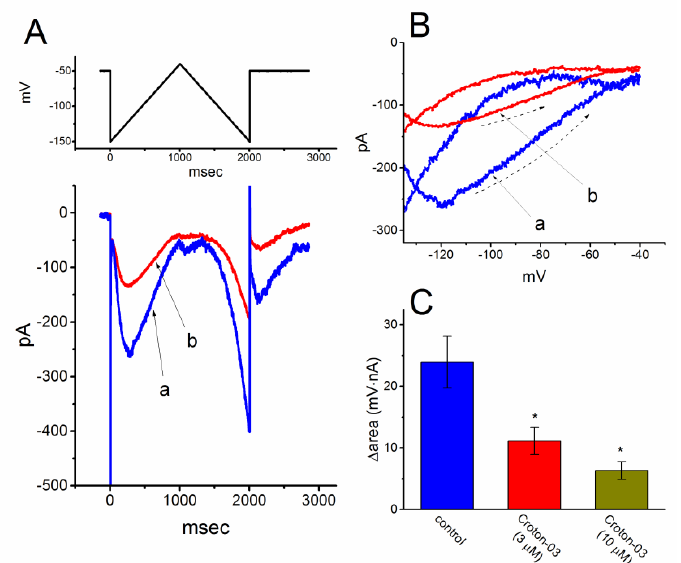
Figure 3. Effect of croton-03 on the voltage hysteresis of I h recorded from GH 3 cells. ( A ) Representative current trace elicited by long-lasting triangular (i.e., upsloping and downsloping) ramp pulse between -150 and -40 mV with a duration of 2 sec. The upper part in (A) is the voltage protocol applied to the examined cell. Current trace labeled a is control and that labeled b was taken in the presence of 3 μM croton-03. ( B ) Voltage hysteresis (i.e., the relationship of forward and reverse current versus membrane voltage) of I h measured in the control (a) and during the exposure to 3 μM croton-03 (b). Dashed arrows show the direction of I h in which time passes during the elicitation of triangular ramp pulse. ( C ) Summary bar graph showing the effect of croton-03 (3 or 10 μM) on the Δarea of voltage hysteresis of I h (mean ± SEM; n = 7 for each bar). * Significantly different from control ( p < 0.05).